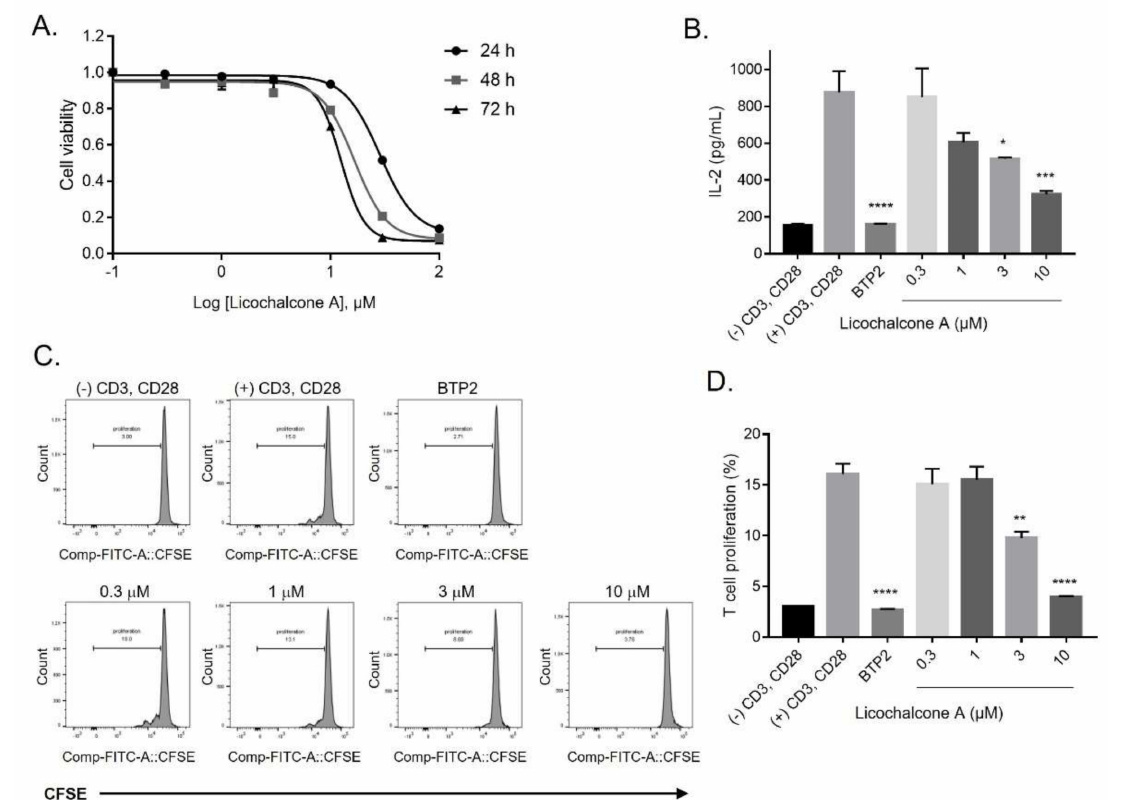
Figure 4. Licochalcone A suppressed IL-2 release and cell proliferation in T-lymphocytes. ( A ) Cytotoxicity curves of licochalcone A in Jurkat T-cells, measured after the cells were exposed to licochalcone A for 24 h, 48 h, and 72 h, using the CCK-8 assay. ( B ) Effect of licochalcone A on the release of IL-2 in CD3 and CD28-stimulated Jurkat T-cells was determined. Licochalcone A-untreated, stimulated cells were used as a control. Data are presented as means ± SEM (n = 3). ( C ) The purified human CD4 + T-cells were costimulated with CD3 and CD28 antibodies and stained with CFSE before treatment with 0.3, 1, 3, and 10 µ M licochalcone A and BTP2. ( D ) The anti-proliferative efficacy of licochalcone A on a CD4 + T-cell population was quantitated. The untreated anti-CD3 and anti-CD28-costimulated cells were used as a control. Data are presented as means ± SEM ( n =